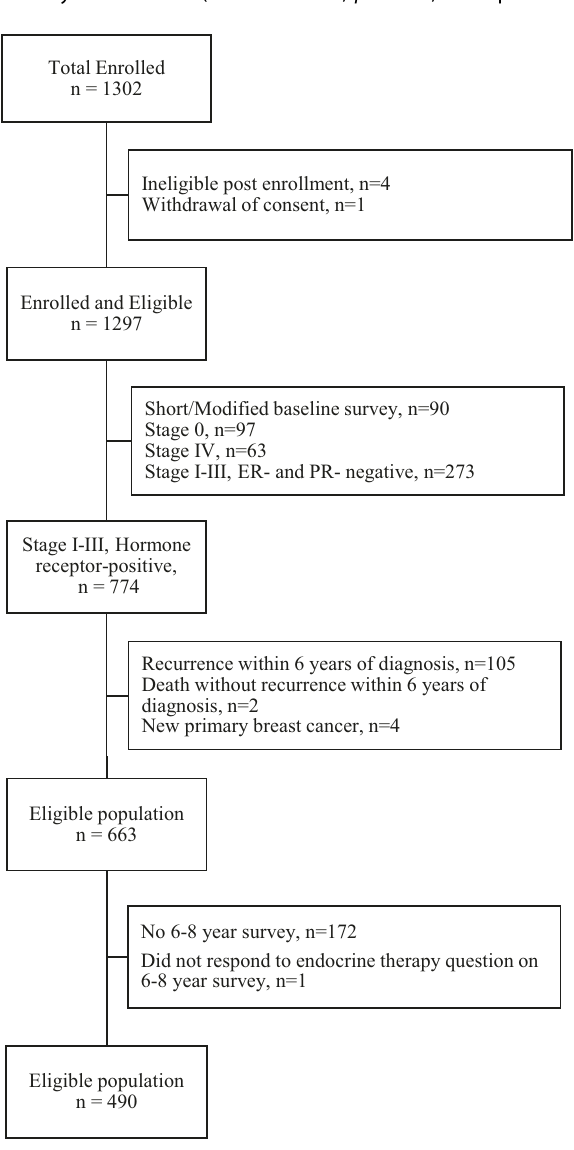
Fig. 1 Study fl owchart. Of 1297 participants enrolled and eligible in The Young Women ’ s Breast Cancer Study, 490 were included in the current analytic cohort. ER estrogen receptor, PR progesterone